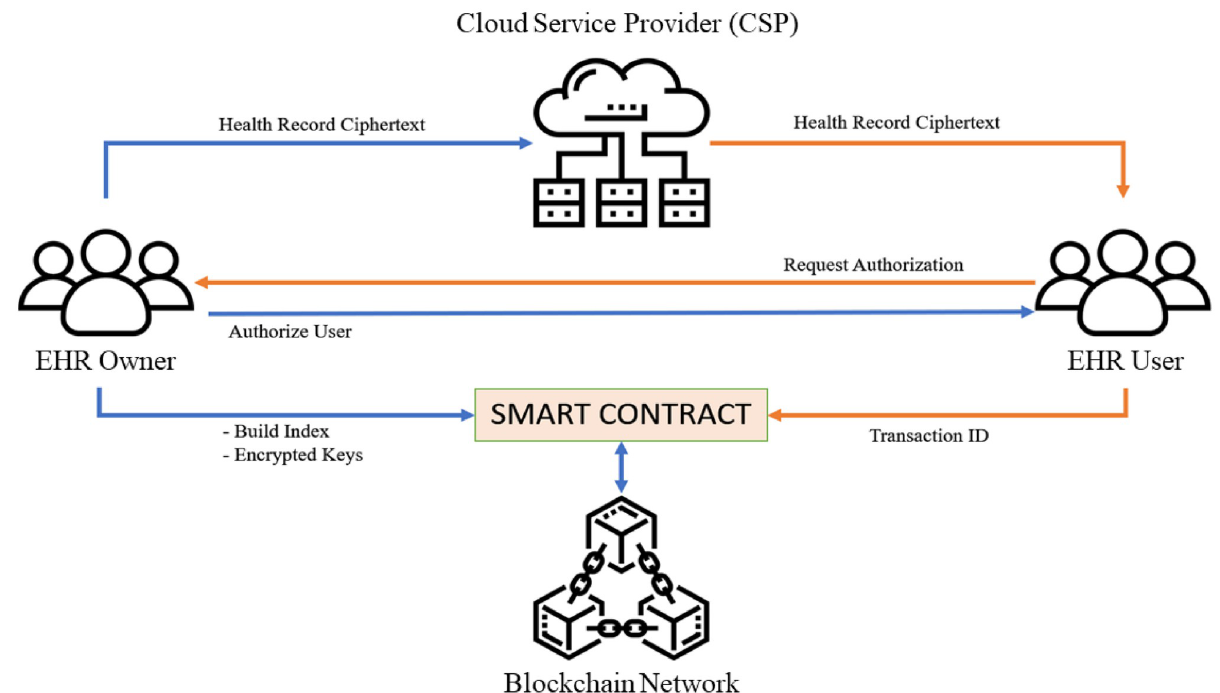
Fig 2. Theoretical framework of the proposed BHMV